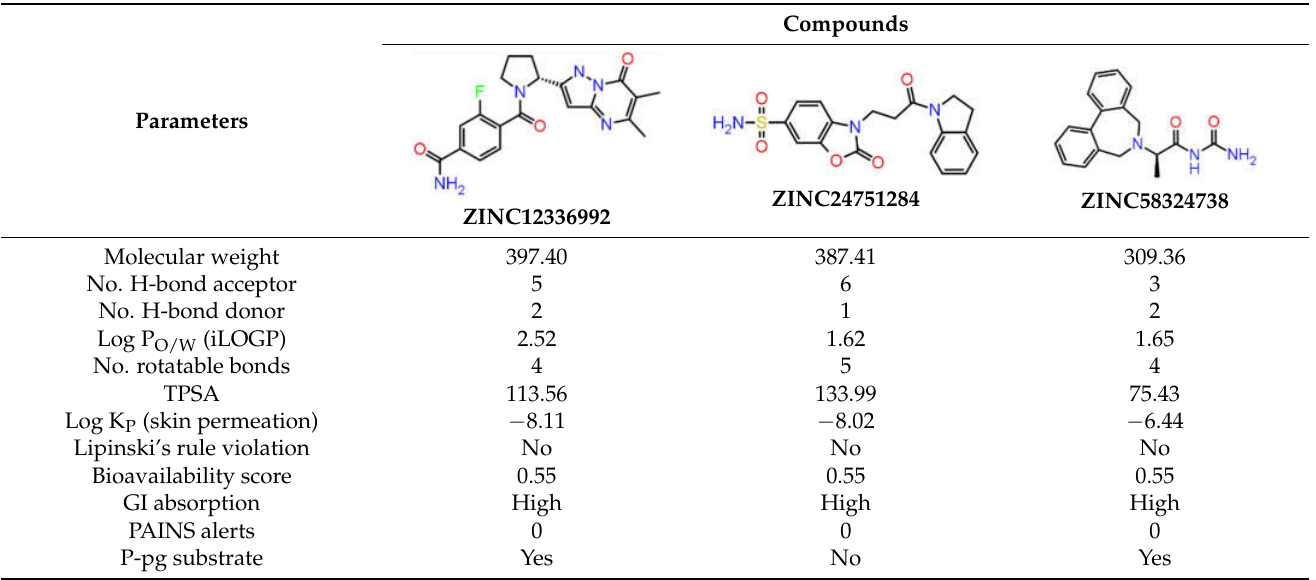
Table 3. ADME prediction of the top three hits.